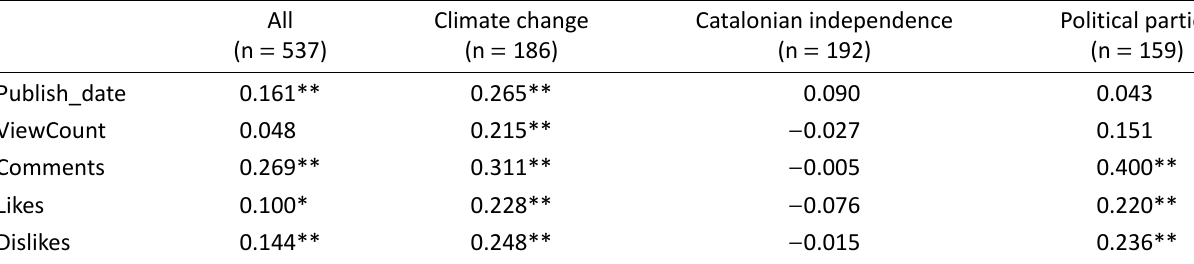
Table 2. Spearman correlations (polarization) (R ). s All Climate change Catalonian independence Political